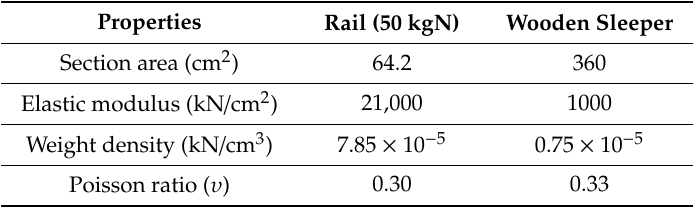
Figure 5. Finite element (FE) model of jointed rail track: ( a ) modeling and boundary conditions; ( b ) components of rail joint (fishplate, bolts and nuts, short rail with hole). Table 2. Material properties of jointed rail track.